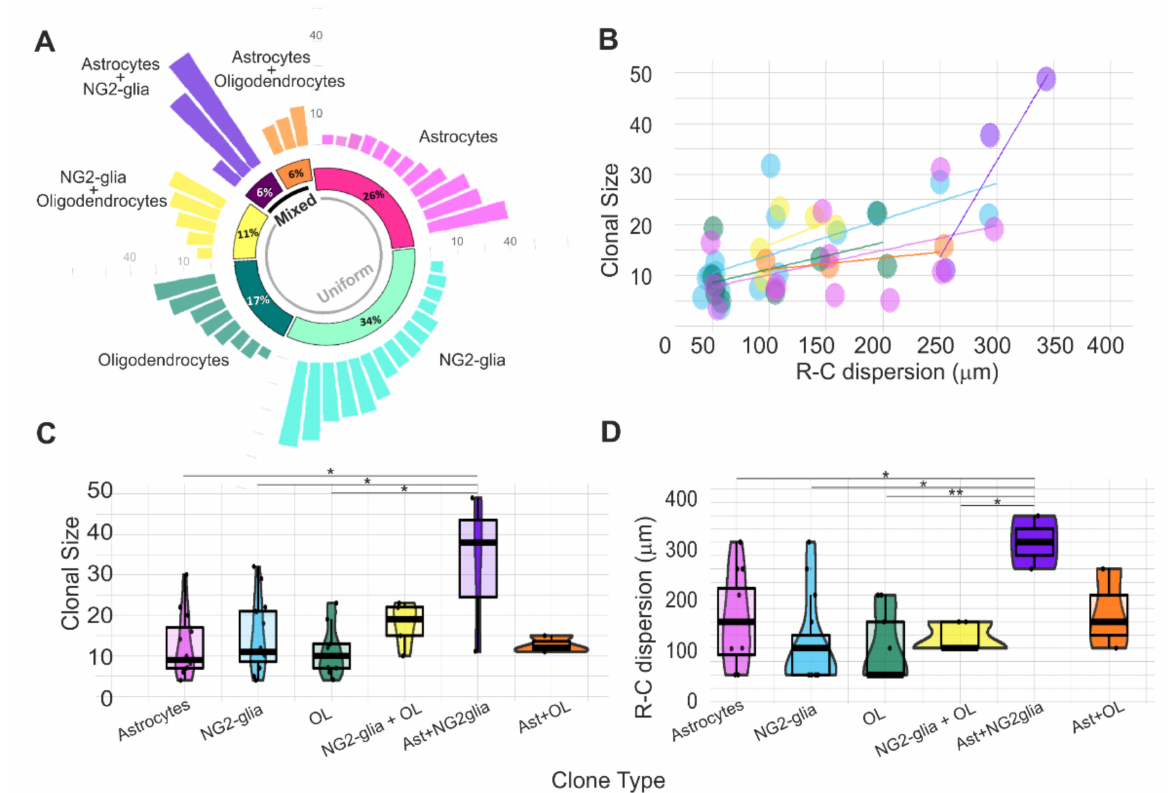
Figure 3. Clonal size and R-C cell dispersion of the glial-derived cell progeny from single pallial E14-RGC progenitors. ( A ) Clonal analysis of mixed and uniform clones from single pallial E14-RGC progenitors: 26% clones of astrocytes ( n = 12 clones), 34% NG2-glia ( n = 15 clones), 17% oligodendroglial clones ( n = 8 clones), and 11% NG2+oligodendroglial clones ( n = 5 clones). Half of the mixed clones comprised NG2 and astrocyte sibling cells, and the other half comprised oligodendrocyte and astrocyte sibling cells. ( B ) Increment in the clonal size related to the R-C cell dispersion. Purple: astrocyte clones; blue: NG2-glia clones; yellow: NG2-glia+oligodendrocyte clones; green: oligodendrocyte clones. ( C ) Number of sibling cells per clone type. ( D ) R-C cell dispersion of clones sorted by the type of clone. R-C dispersion in B and D corresponds to the extension of sibling cells in microns. Every point represents a clone. Ast: astrocytes; OL: oligodendrocytes. * p < 0.05; ** p <